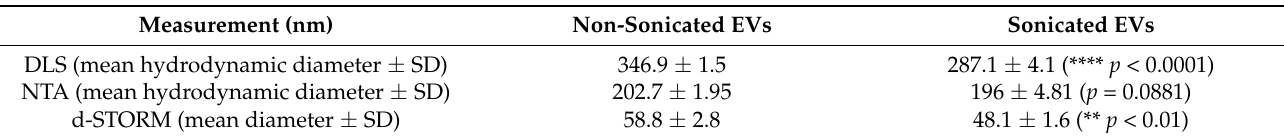
Table 1. Average EV size determined by DLS, NTA and d-STORM measurements; N = 3; unpaired two-tailed parametric student’s